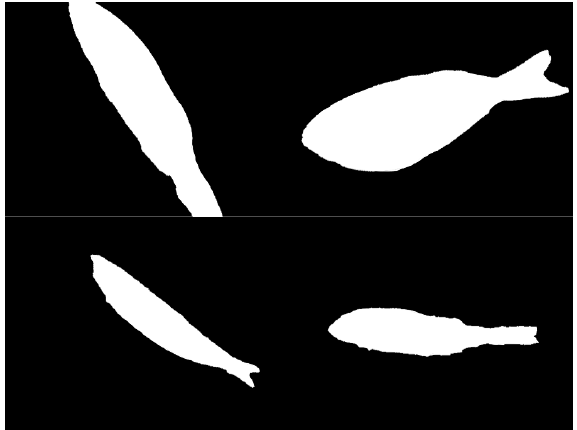
Figure 14. The segmentation results of LinkNet.